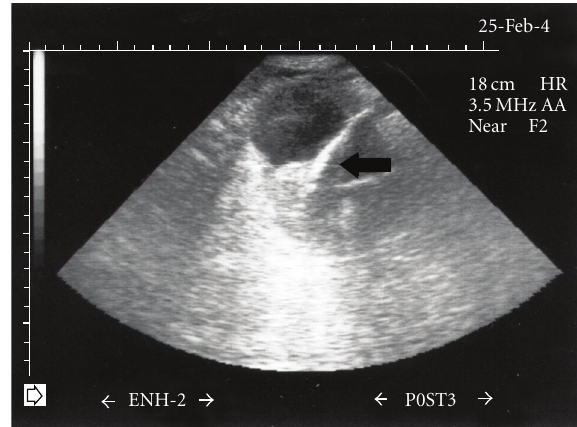
Figure 5: The piece of pencil after the surgical